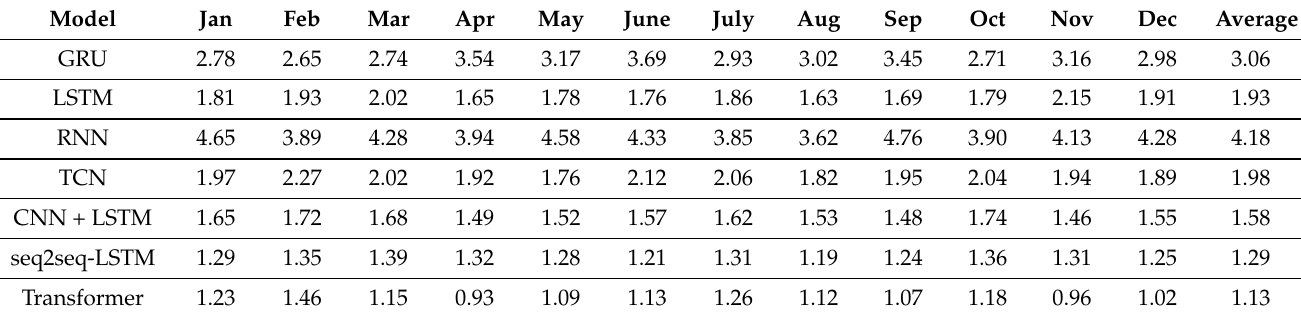
Figure 14. Day-ahead prediction of transformer-based model in different seasons. Table 1. MAPE of three models in